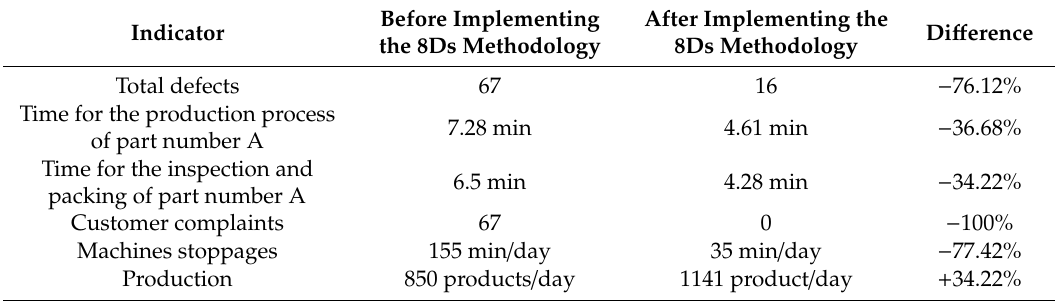
Table 5. Comparison of the main indicators before and after applying the 8Ds